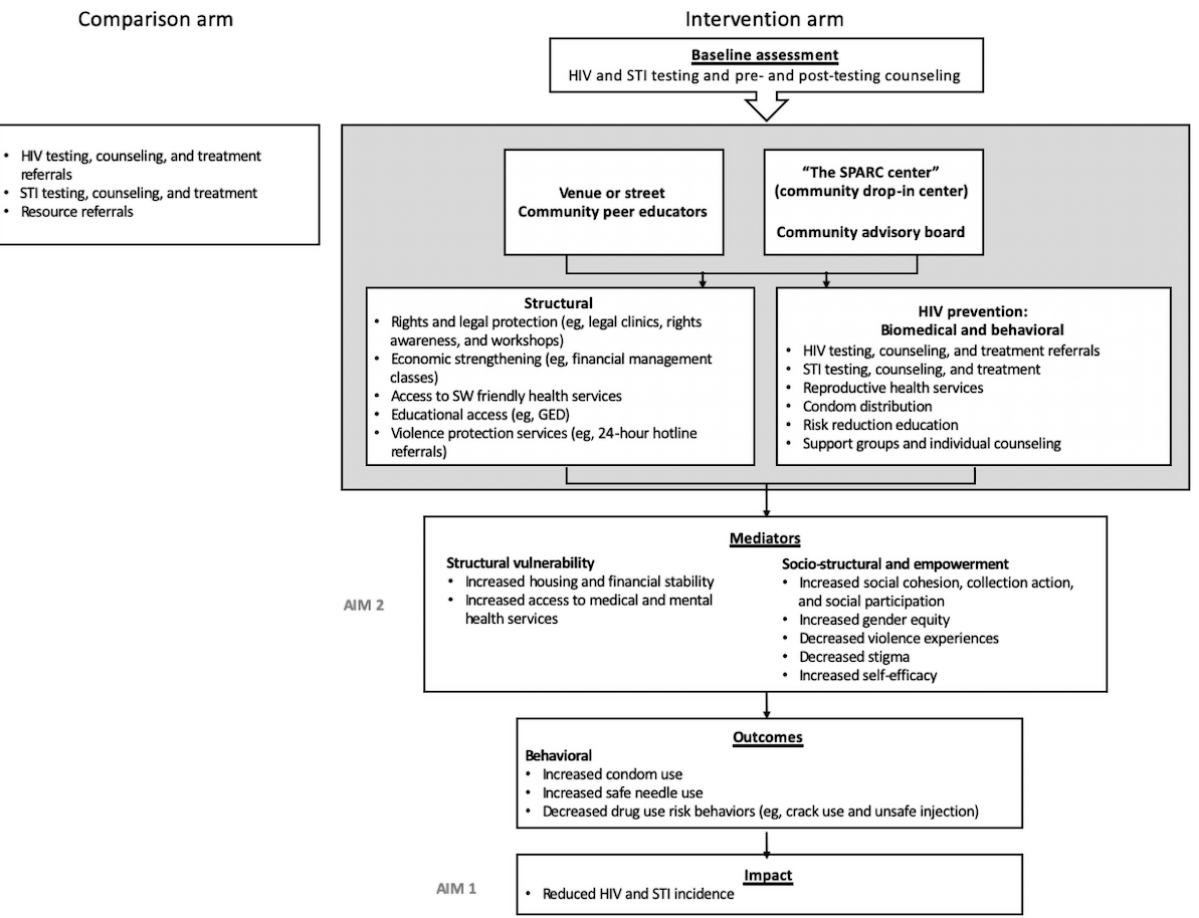
Figure 1. EMERALD (Enabling Mobilization, Empowerment, Risk Reduction, and Lasting Dignity) study theoretical framework. GED: general educational development; SPARC: Sex Workers Promoting Action, Risk Reduction, and Community Mobilization; STI: sexually transmitted infection; SW: sex